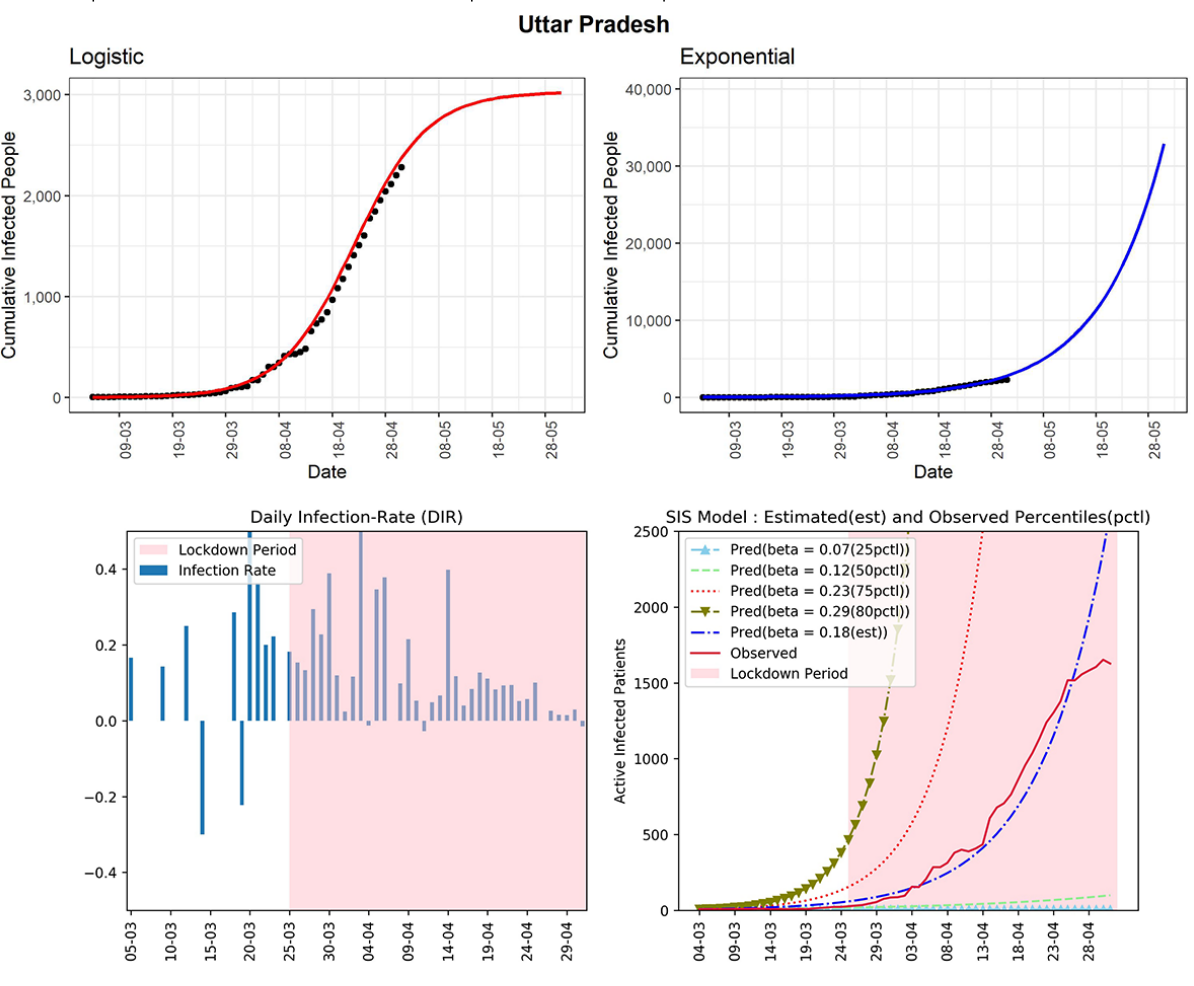
Figure 10. Graphs for the state of Uttar Pradesh. SIS: